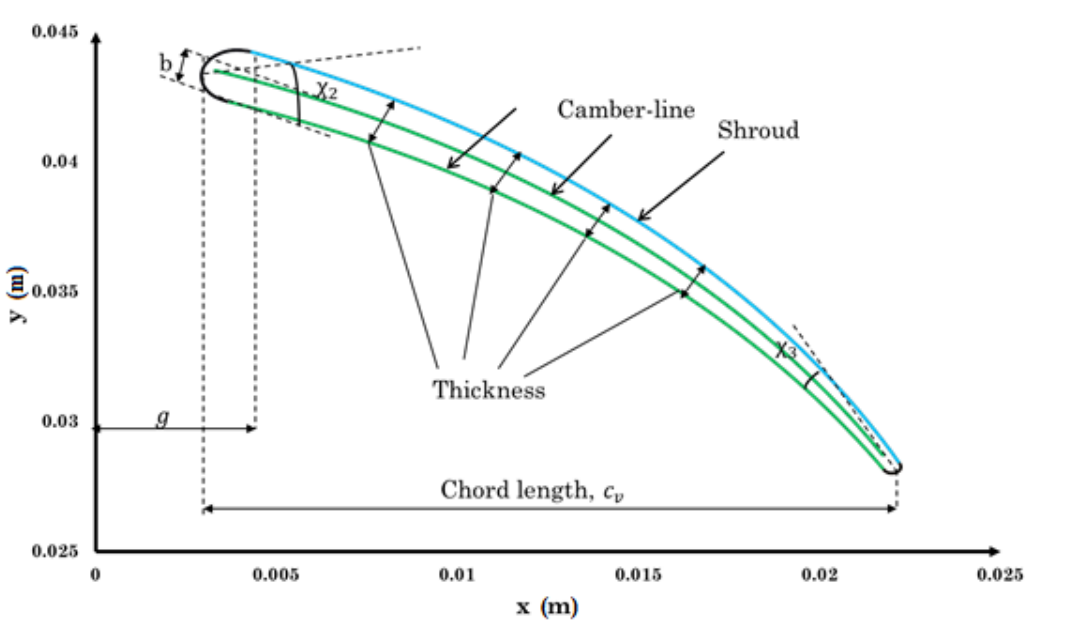
Figure 4. Creation of stator 3D model.